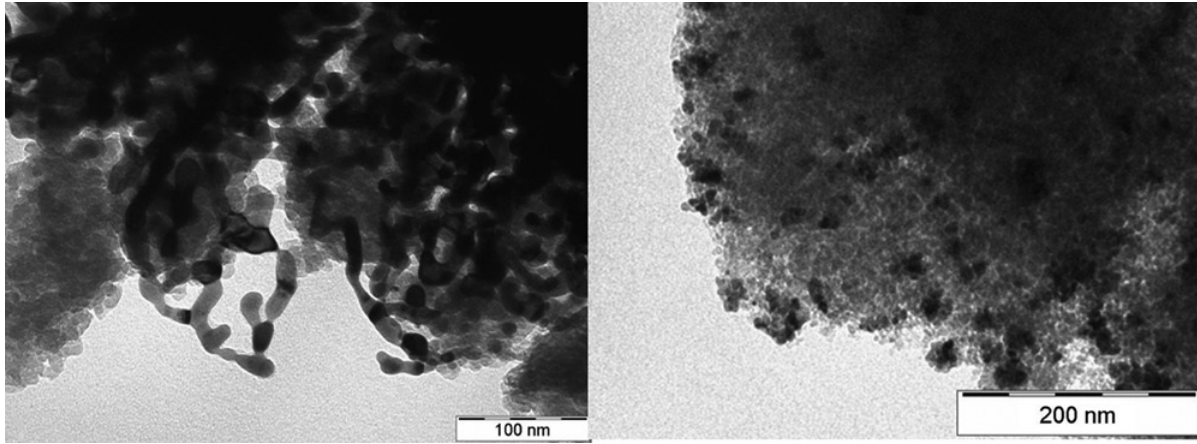
Figure 3: TEM images of spent CAT-1/1 (left) and CAT-2/1 (right) after two runs (with 8-h reaction